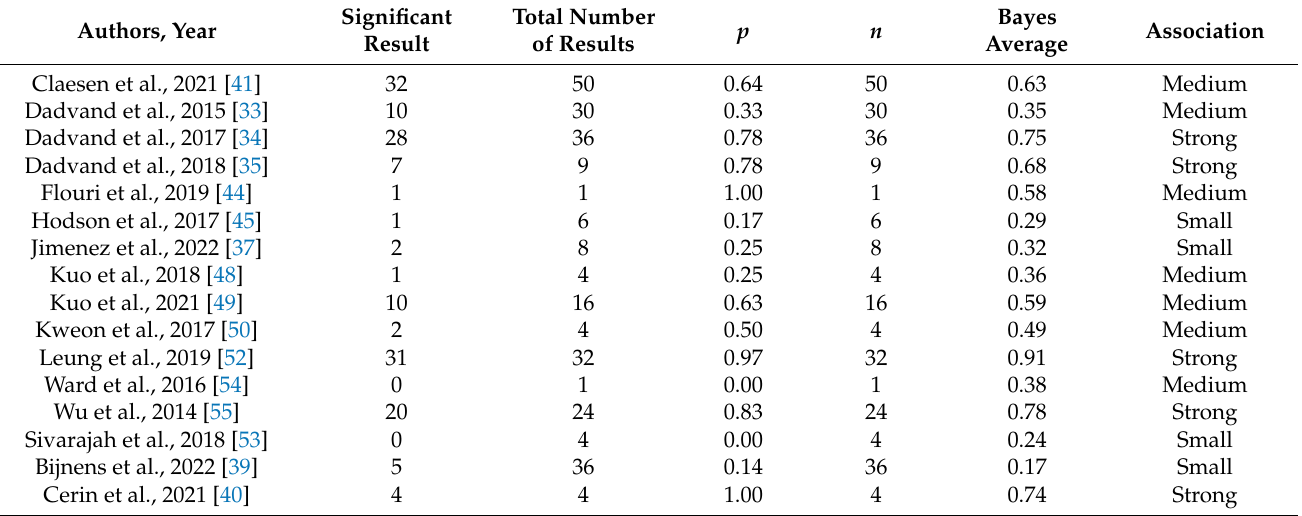
Table 2. Associations between greenness and cognitive functions classified according to the Bayesian average